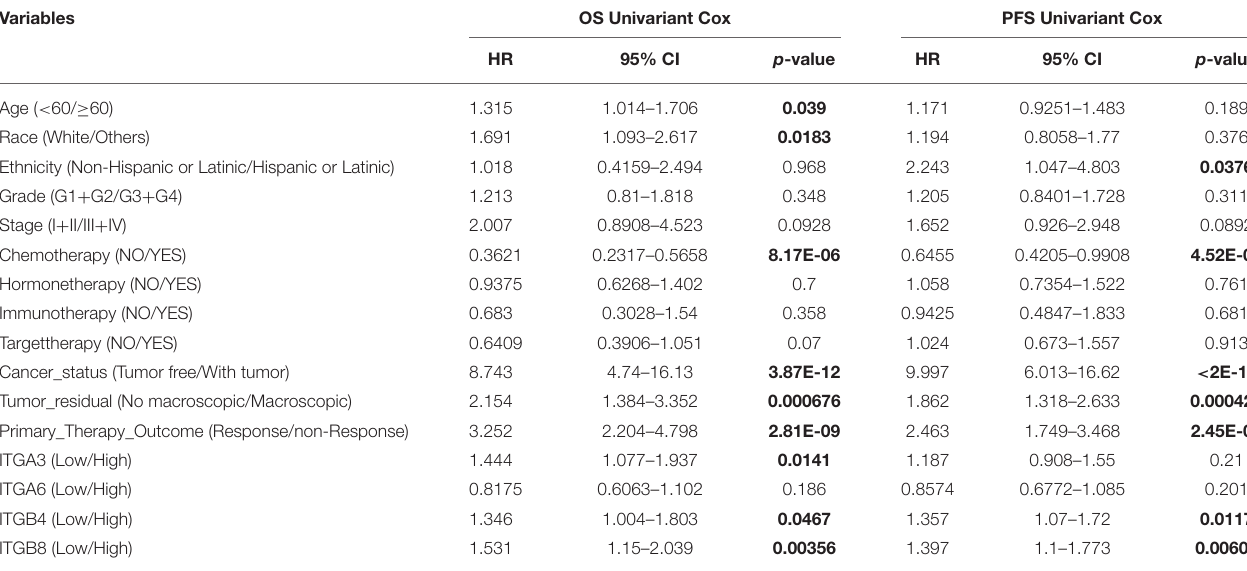
TABLE 4 | Univariant Cox regression analysis of OS and PFS in OC patients.